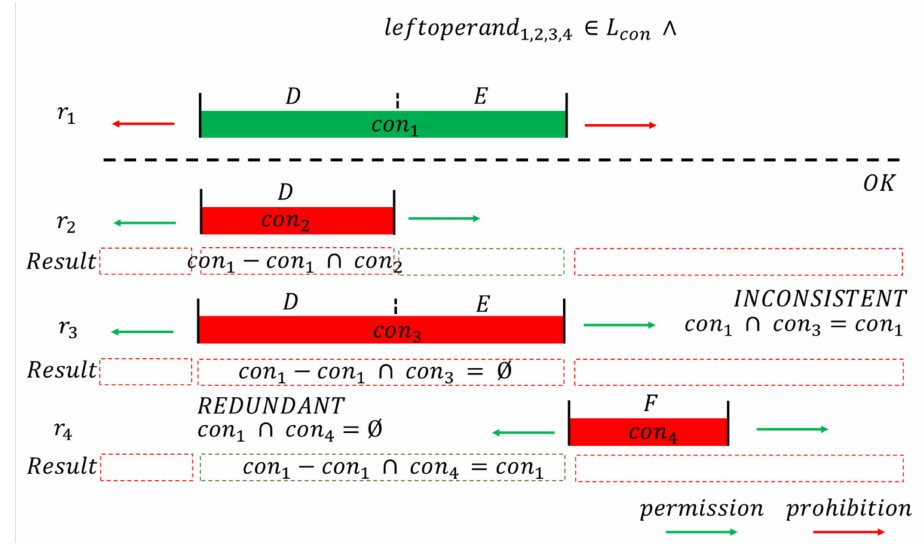
Figure 5. Common Resource Conflict Detection. Whitelisting + Blacklisting Approach.